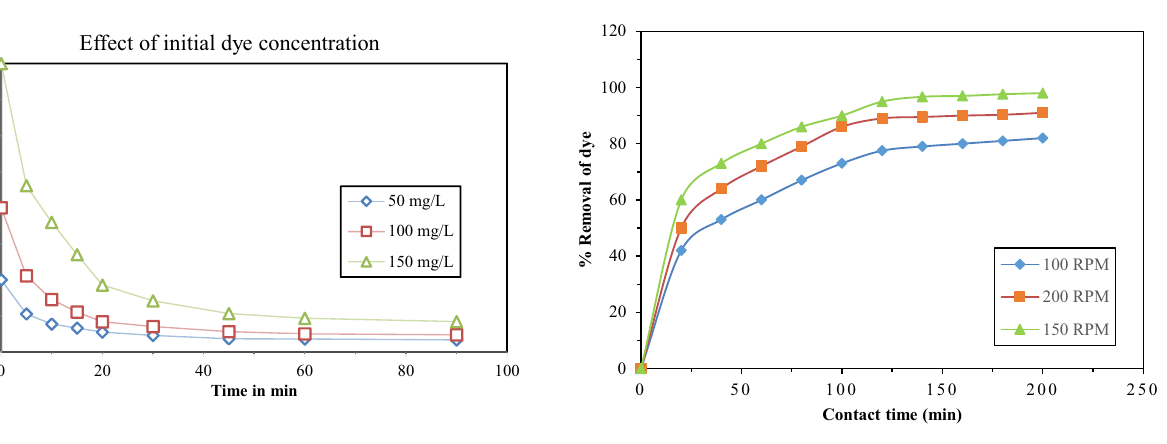
Fig. 8 Percentage removal of dye for different